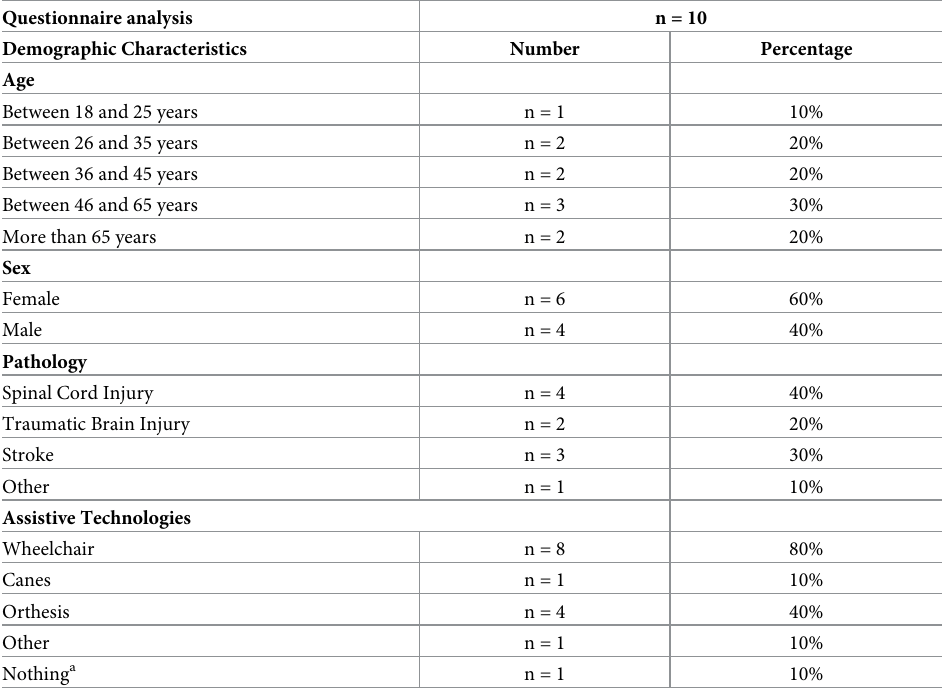
Table 5. Demographic characteristics users from the questionnaire